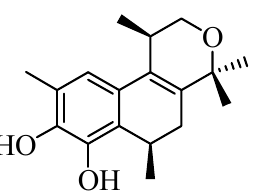
Figure 1. Structure of populene